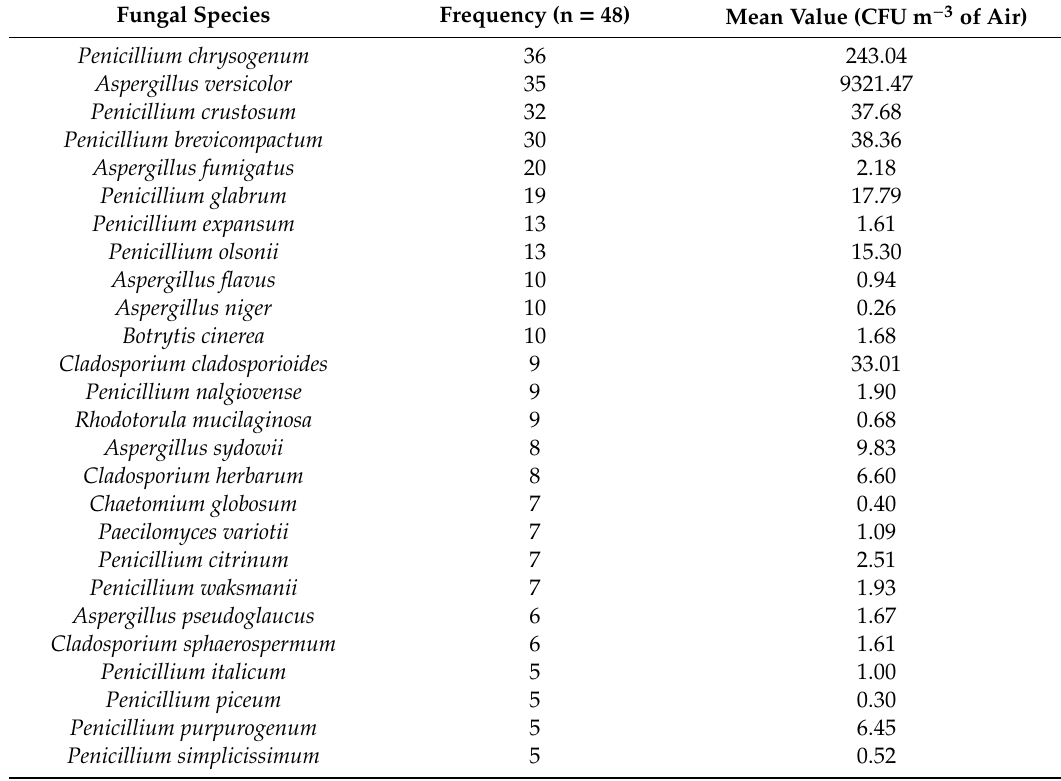
Table 3. Molds identified from bioaerosols in mold-damaged homes (n = 48) at a frequency above 10%. Fungal